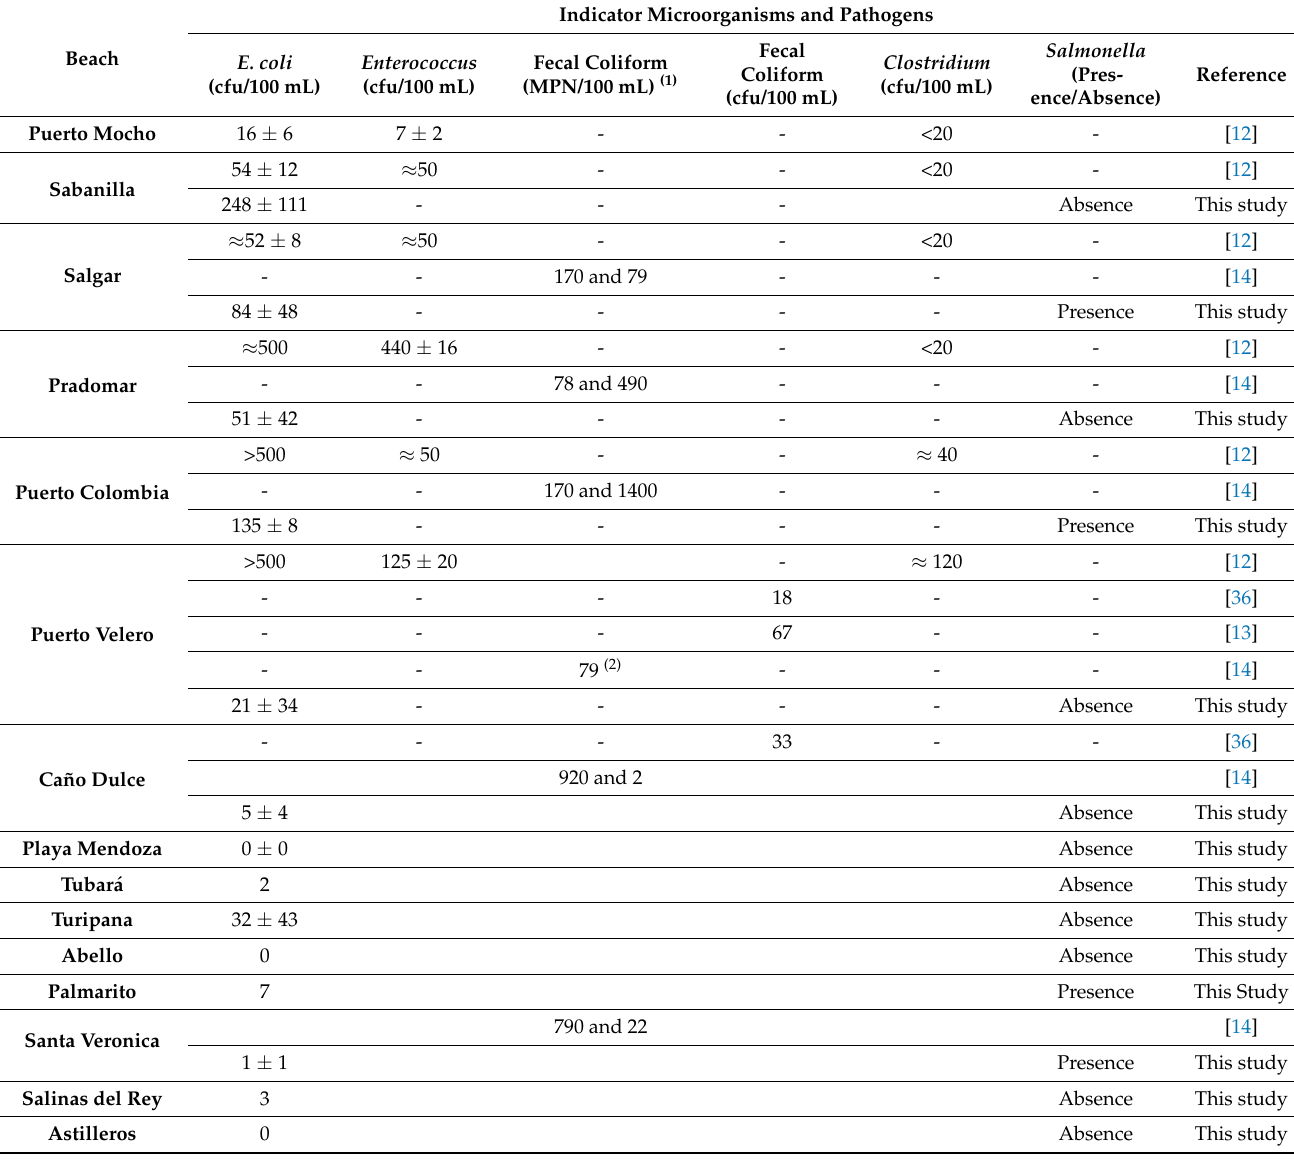
Table 3. Seawater microbiological parameters recorded by different authors along the department of Atl á ntico. Indicator Microorganisms and Beach